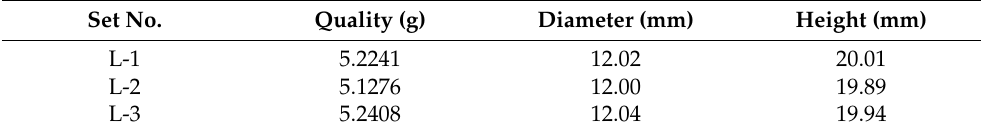
Figure 6. Limestone sample: ( a ) limestone parent rock; ( b ) limestone cylinder test piece. Table 2. Diameters, heights, and quality of limestone cylinders. Table 2. Diameters, heights, and quality of limestone cylinders.